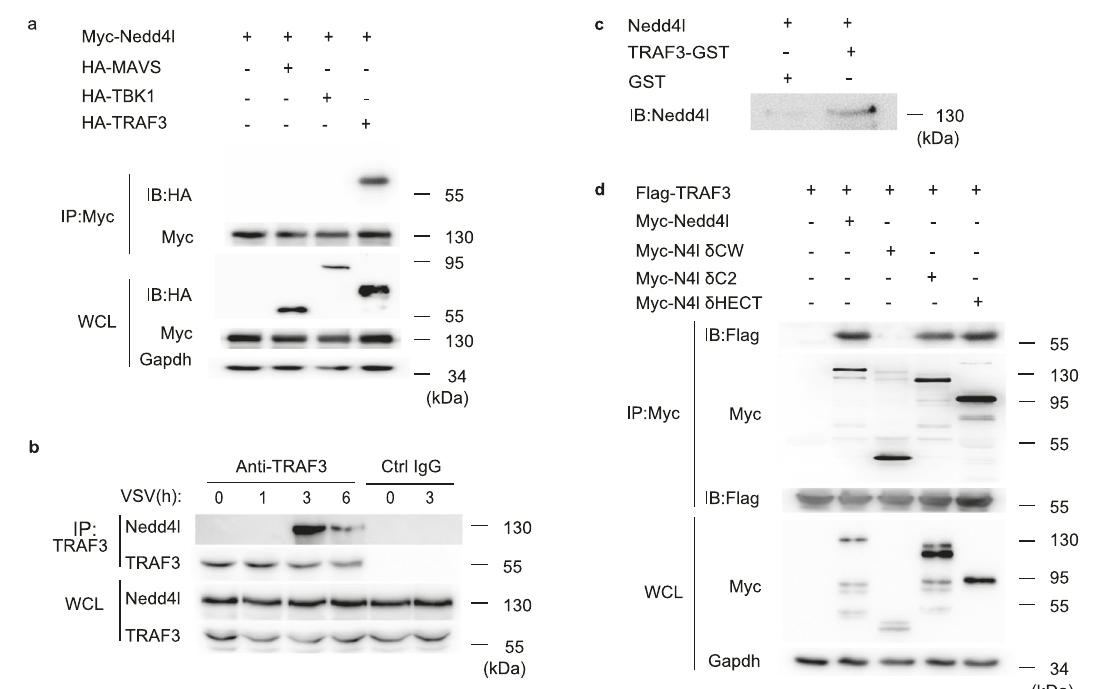
Fig. 4 Nedd4l interacts with TRAF3. a IB of HA-MAVS, HA-TBK1, HA-TRAF3, and Myc-Nedd4l co-immunoprecipitated with anti-Myc from lysates of 293T cells transfected with indicated plasmids with HA-tag, Myc-tag, or GAPDH antibodies. b IB of TRAF3 and Nedd4l co-immunoprecipitated with anti- TRAF3 from lysates of C57BL/6 mice peritoneal macrophages infected with VSV (MOI = 10) for indicated time. c In vitro GST-pull-down assay of Nedd4l with GST or GST-fused TRAF3. d IB of TRAF3 and Nedd4l co-immunoprecipitated with Myc-tag-speci fi c antibody from lysates of 293T cells co-transfected with plasmids expressing Flag-TRAF3 and Myc-tagged wild-type Nedd4l or mutant Nedd4l with CW ( Δ CW),C2 ( Δ C2), or HECT ( Δ HECT) domain deleted. Results in ( a – d ) are representative of three independent